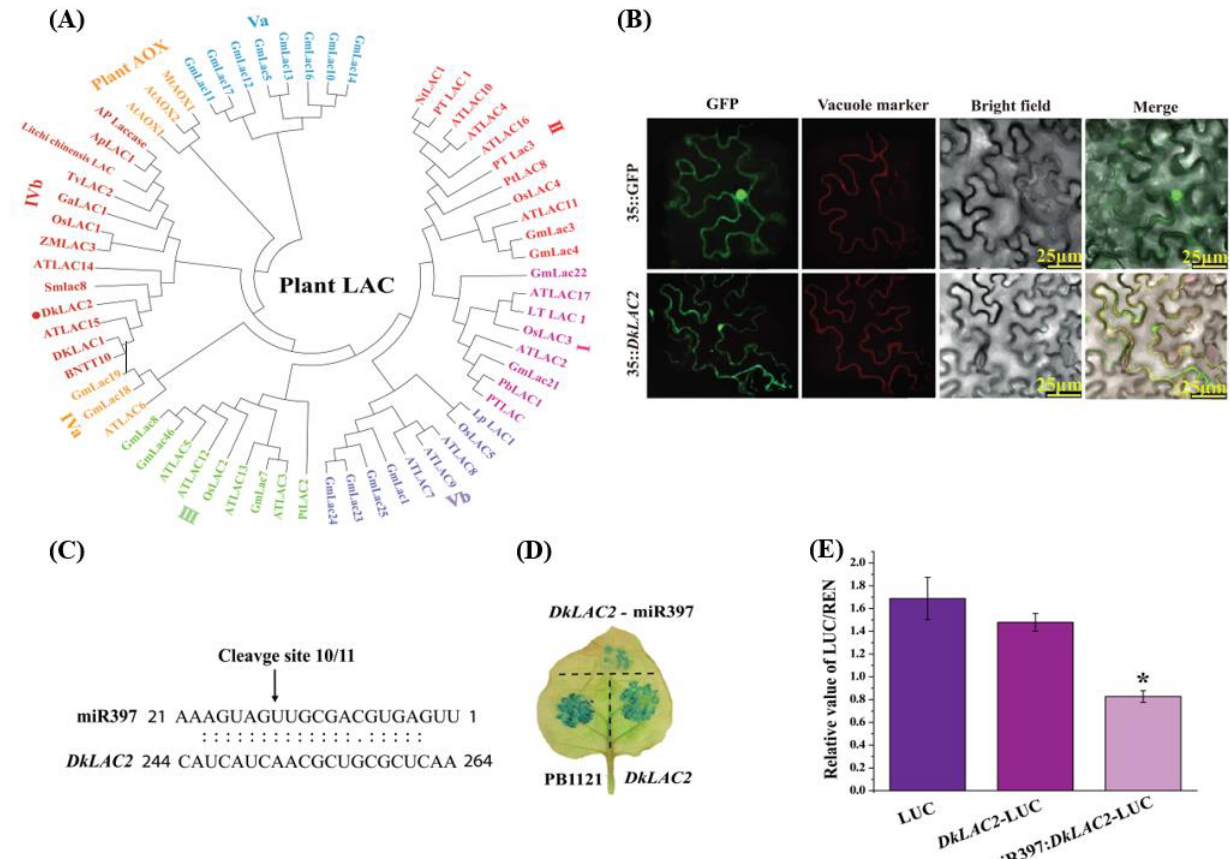
Figure 2. Identification and characterization of DkmiR397 and DkLAC2 . ( A ) Phylogenetic tree of DkLAC2 homologs. The protein names from various plant species are labeled on the branches. Bootstrap replicates 3000 were used to calculate the bootstrap values. ( B ) Subcellular localization of the DkLAC2 proteins. ( C ) Target validation for DkmiR397 by RLM-5 (cid:48) RACE. The cleavage sites are indicated by arrows, and the values represent the frequency of accurately sequenced clones. ( D ) GUS (histochemical β -glucuronidase) was a co-expression of DkmiR397 and its target genes in tobacco leaves via Agrobacterium tumefaciens -mediated transformation. ( E ) The interaction between DkmiR397 and its target genes was demonstrated using a Dual-LUC assay. Renilla (REN) luciferase activity was used to standardize relative LUC activity. Error bars indicate SEs from four biological replicates ( n = 4). Asterisks above the bars represent values determined to be significantly different from the control by the Student’s t -test (* p <